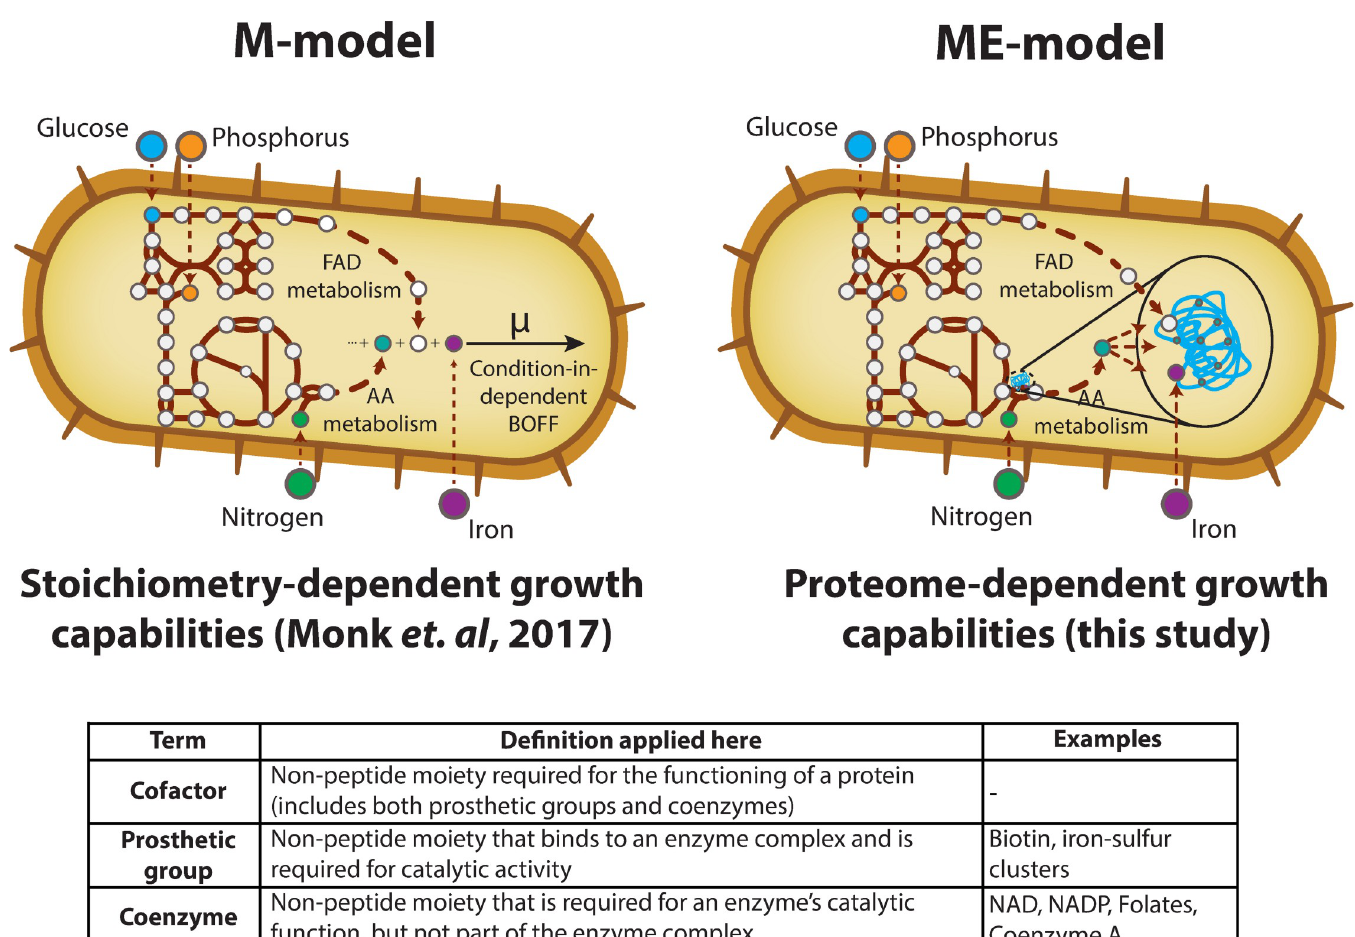
Fig 1. Difference in M- and ME-model scope. M-models offer a means to comprehensively probe the capabilities of enzymatic conversions possible within an organism. This modeling method is based on the stoichiometry of reactions in the organism’s metabolic network and can be used to predict possible growth supporting nutrient environments (demonstrated in Monk et al .) [25,26].By mechanistically accounting for enzyme synthesis and activity, ME-models add additional information about the proteome sustaining the growth state. Thus, ME-models offer the ability to study how proteome allocation and cofactor use affects condition-dependent growth. Due to the inconsistency in how the terms cofactor , prosthetic group , and coenzyme are used in the scientific literature, the definitions applied in this study are listed in the table.